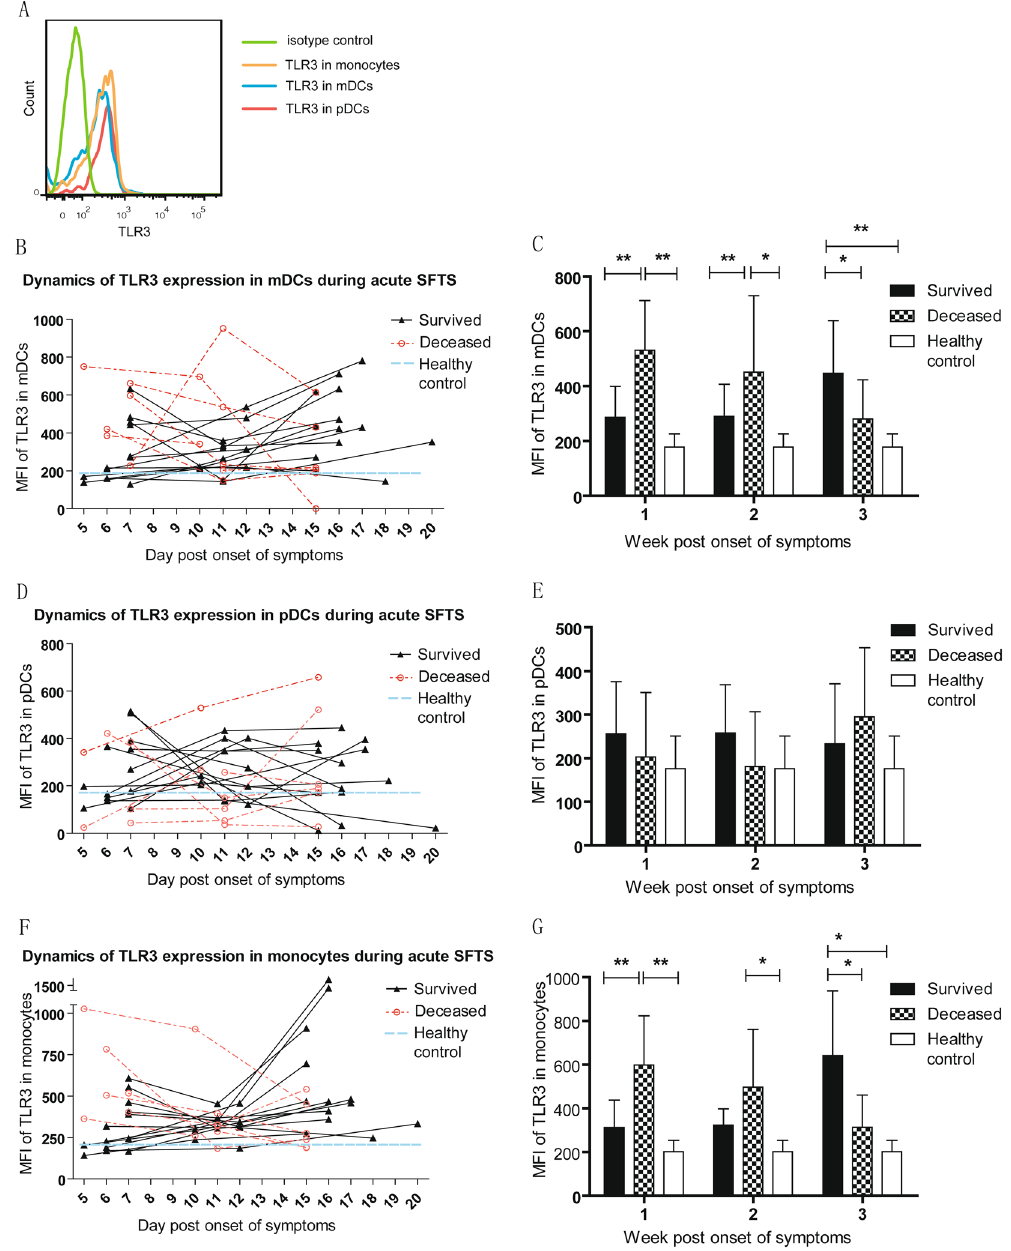
Figure 5. Dynamics of Toll like receptor 3 (TLR3) expression by circulating mDCs, pDCs and CD14 + HLA-DR + monocytes of SFTSV infected patients during acute phase. Representative histograms of TLR3 expression by mDCs, pDCs and monocytesare shown in Fig. 5A. Dynamics of TLR3 expressionby mDCs, pDCs and monocytes from 13 survived and seven deceased patients during acute phase of SFTS, measured by mean fluorescence intensity (MFI), are shown in Fig. 5B,D and F. Mean Fluorescence Intensity (MFI) of intracellular TLR3 expression by the cells of all day points are categorized into the first week (1~7 th day), the second week (8~14 th day) and the third week (15–21 th day) post onset of symptoms, and bar graphs (Fig. 5C,E and G) compare the mean ± SD of MFI of TLR3 by mDCs, pDCs and monocytes in three different weeks. TLR3 expression by mDCs, pDCs and monocytes fromten healthy donors, measured by mean fluorescence intensity (MFI), were assessed as normal controls and plotted in Fig. 5B,D and F as well as in Fig. 5C,E and G. * P < 0.05, ** P <